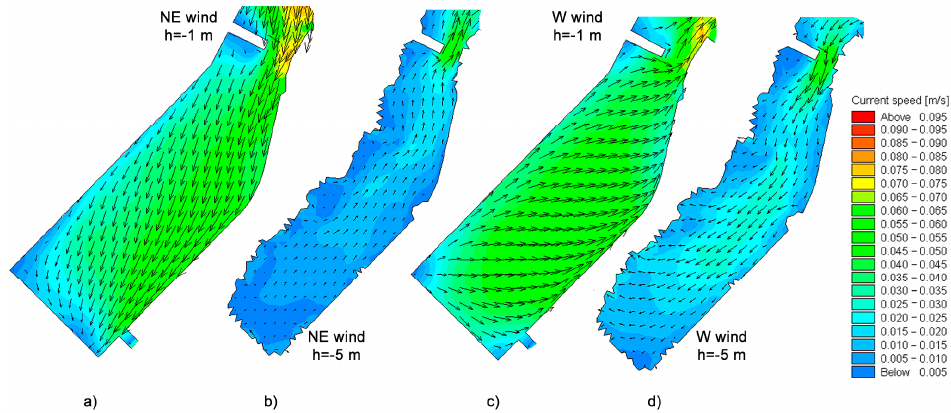
Figure 12. Hourly averaged current fields in the characteristic situations during an occurrence of barocline compensation currents in the area of the marina entrance, induced by ( a , b ) NE wind episode on 7 March 2017, 23:00 h, at a depth ( a ) h = − 1 m and ( b ) h = − 5 m; ( c , d ) W wind episode on 10 August, 17:00 h at a depth ( c ) h = − 1 m and ( b ) h = − 5 m.